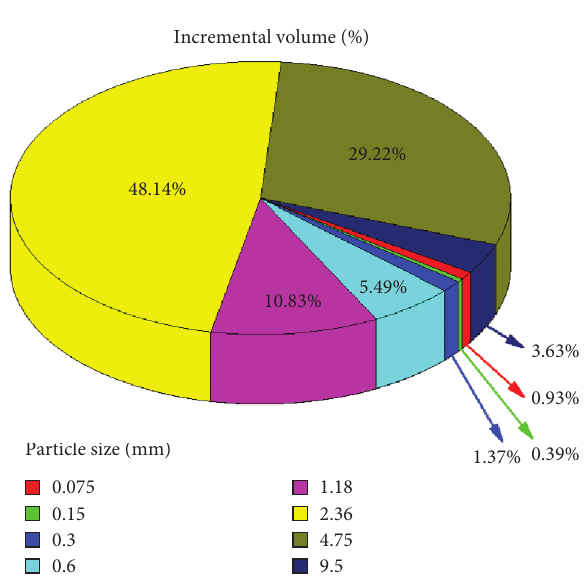
Figure 1: Particle size distribution of tailings.